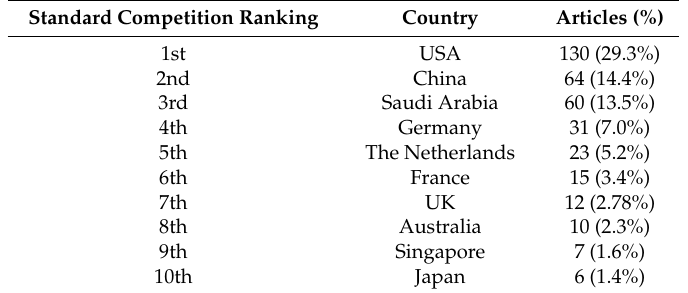
Table 3. Ten most productive countries with MERS articles during the period from 2012 to 2015.